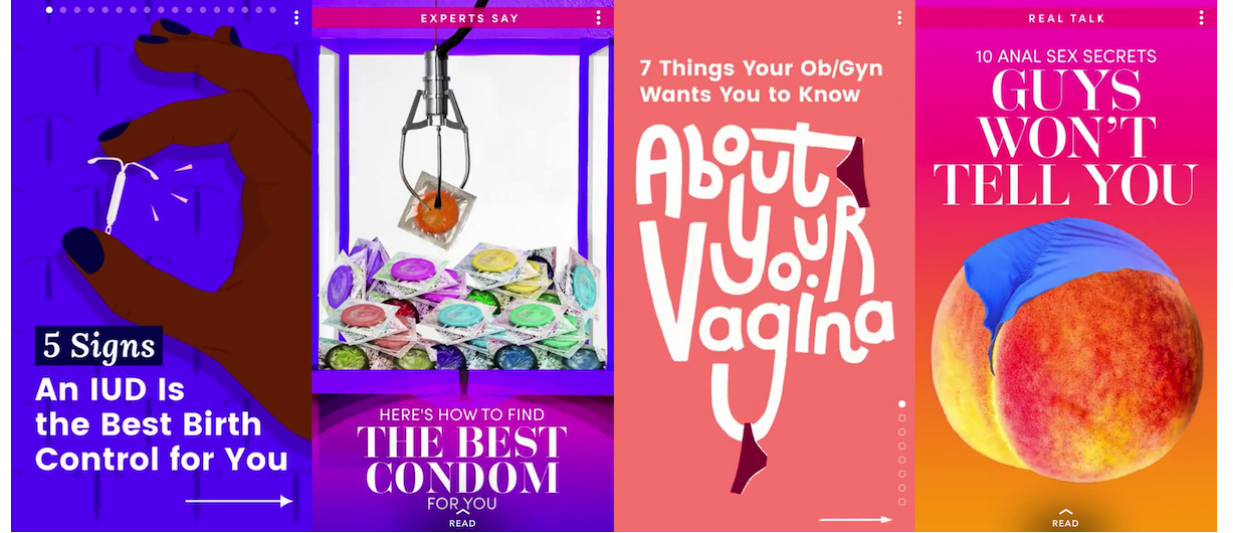
Figure 4. Examples of sexual health topics posted to female-focused Discover